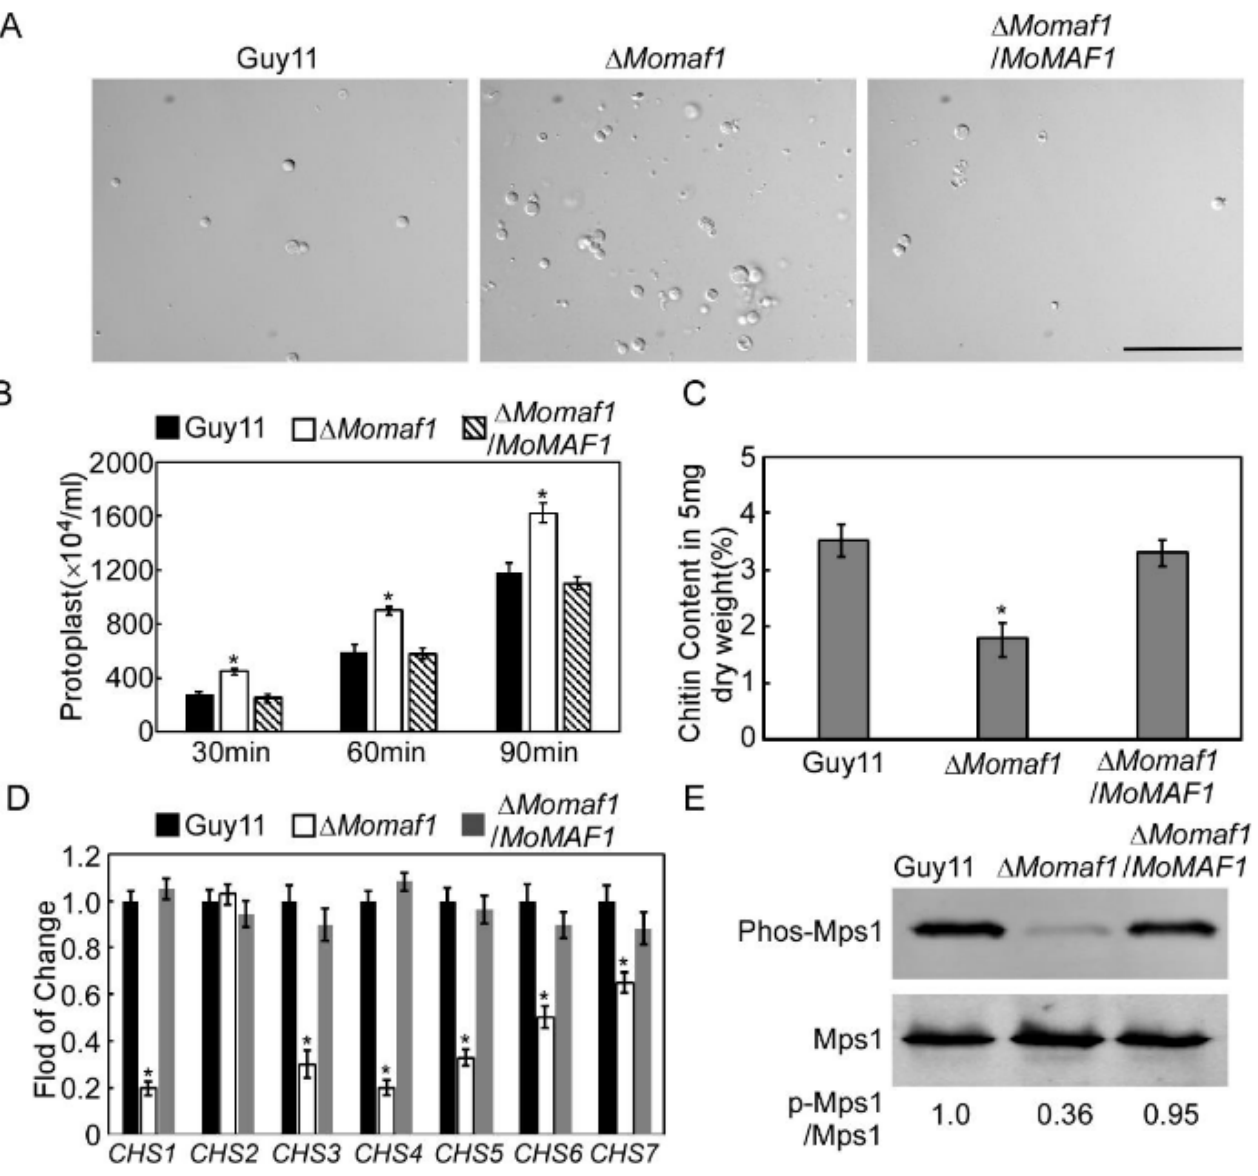
Figure 5. MoMaf1 is involved in cell wall integrity: ( A ) Light microscopic examination of protoplast release after treatment with cell wall-degrading enzymes for 90 min at 30 ◦ C. Scale bar, 50 µ m. ( B ) Statistical analysis of the protoplast number. The protoplast number was calculated at 30, 60, and 90 min. Error bars represent ± SD, and asterisks denote significant differences ( p < 0.01). ( C ) The chitin content was measured in the wild-type Guy11 and ∆ Momaf1 mutant hyphae. The experiment was repeated at least three times with three replicates each time. ( D ) The expression profiles of seven CHS genes in the Guy11, ∆ Momaf1 mutant, and complemented strain. ( E ) Total proteins of the Guy11 and ∆ Momaf1 mutant strains were isolated from mycelia to detect the MoMps1 phosphorylation level using the anti-phospho-p44/42 MAP kinase antibody, and the anti-p44/42 MAP kinase antibody was used as a control. The numerical values indicate the ratio of phosphorylated MAPK/endogenous MAPK, and the ratio of phosphorylated MAPK/endogenous MAPK in the Guy11 strain was defined as 1. Relative band intensity was quantified by IMAGEJ software . Three independent experiments that showed similar results were carried out. Asterisks represent signifigant differences ( p < 0.01).